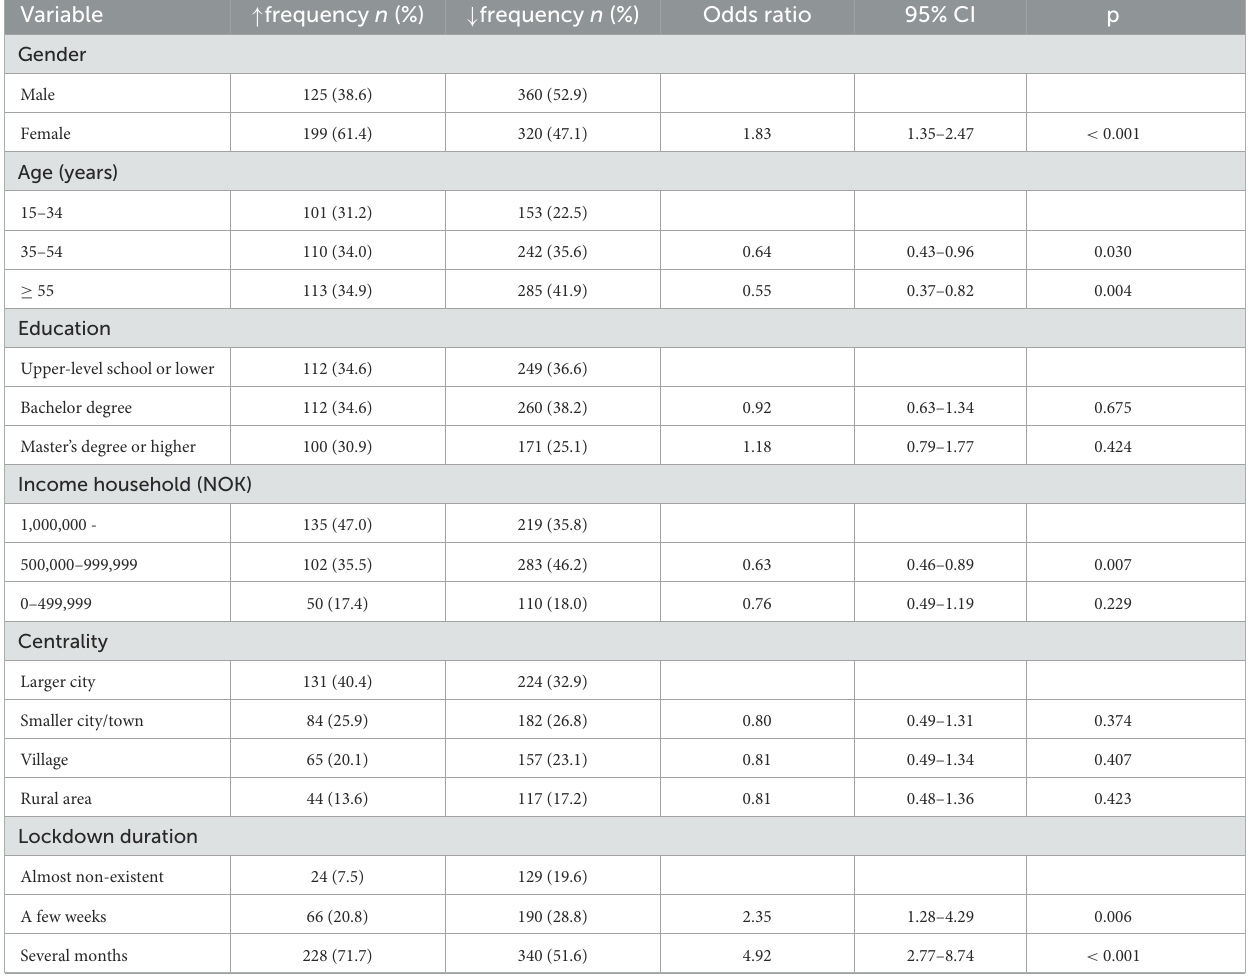
TABLE 3 Sociodemographic characteristics and lockdown duration, for participants that increased the frequency of nature visits and those who did not, and their associations with increased frequency of nature visits reported as odds ratios with 95% confidence interval ( n = 1,004).